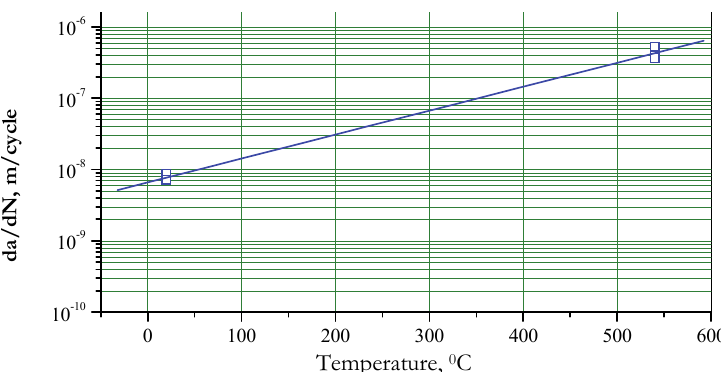
Figure 7: Fatigue crack growth rate, da/dN, vs. temperature for specimens with notches in WM.